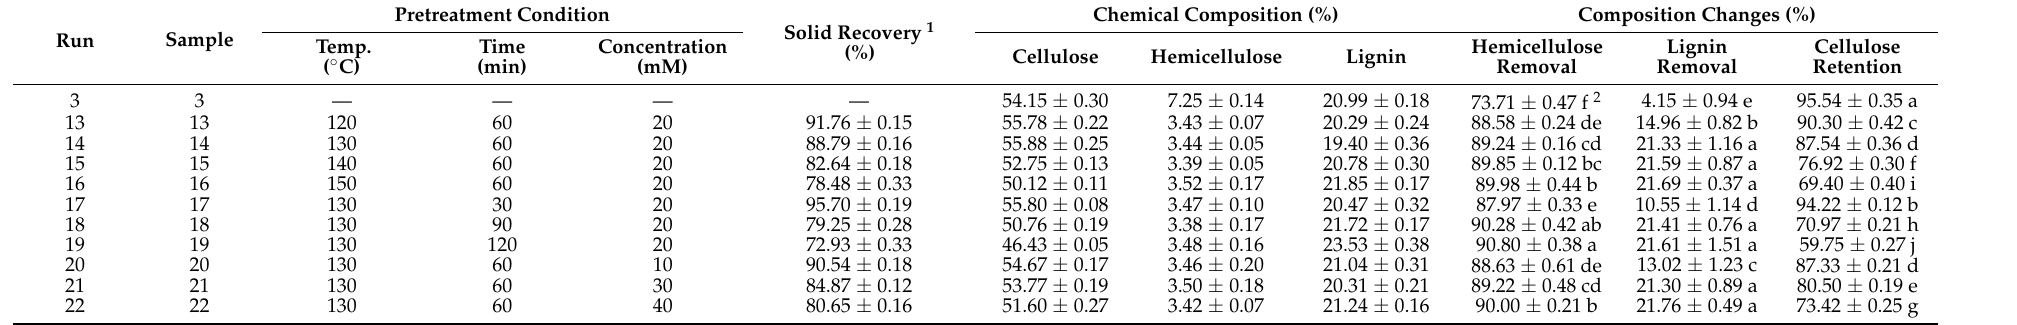
Table 1. Changes in chemical components of rice straw samples before and after PTA pretreatment.